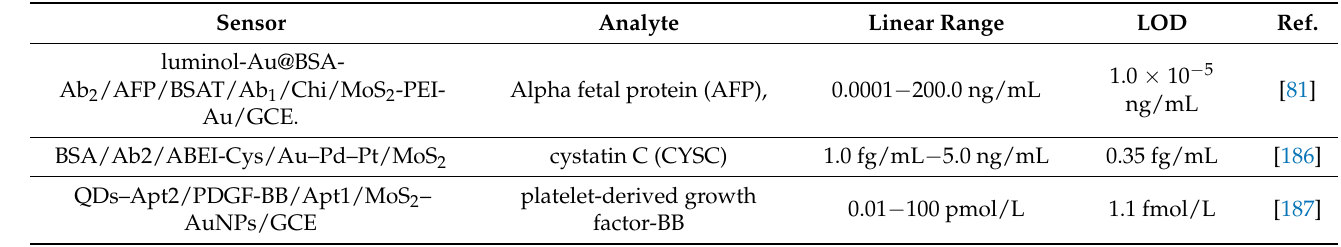
Table 5. Electrochemiluminescence sensors based on 2D-MoS 2 /metal-NSs composites. Sensor Analyte Linear Range LOD Ref. luminol-Au@BSA- Au/GCE. BSA/Ab2/ABEI-Cys/Au–Pd–Pt/MoS